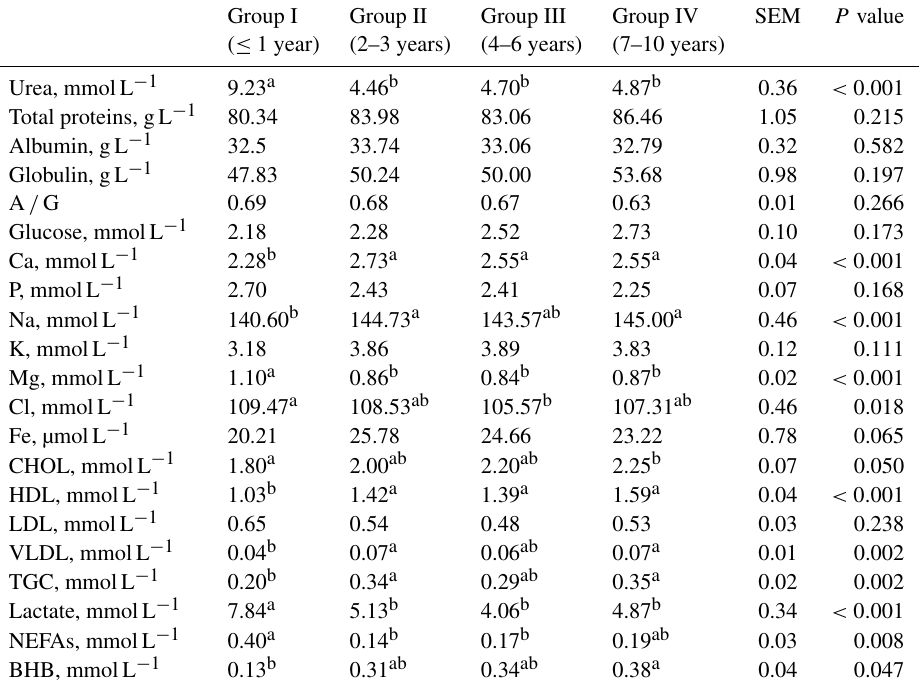
Table 3. Blood biochemical parameters from goats of different